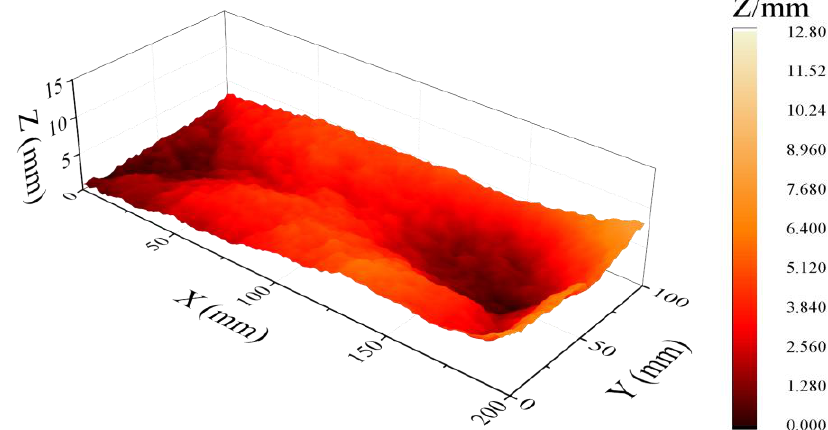
Figure 5. Surface morphology roughness scan of the shear surface.